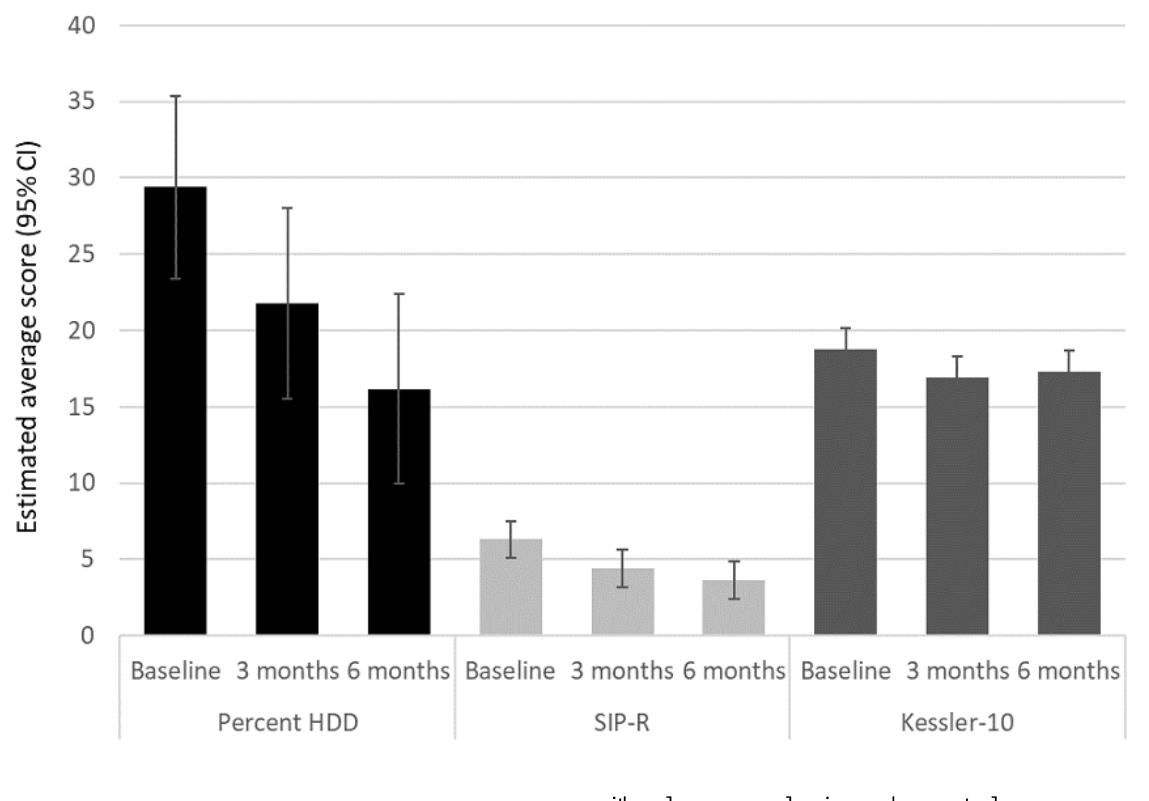
Figure 3. Estimated alcohol use and psychological distress scores over time, adjusted for gender, age, and binary measures of alcohol use disorder, any drug use, and mental health disorder (major depression, generalized anxiety, and posttraumatic stress disorder). HDD: heavy drinking days; SIP-R: Short Inventory of